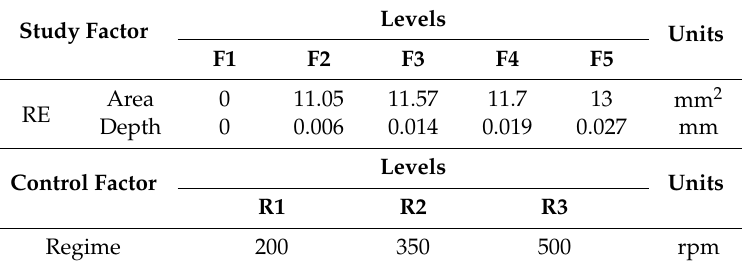
Table 3. Factors and levels considered in the design of experiment.